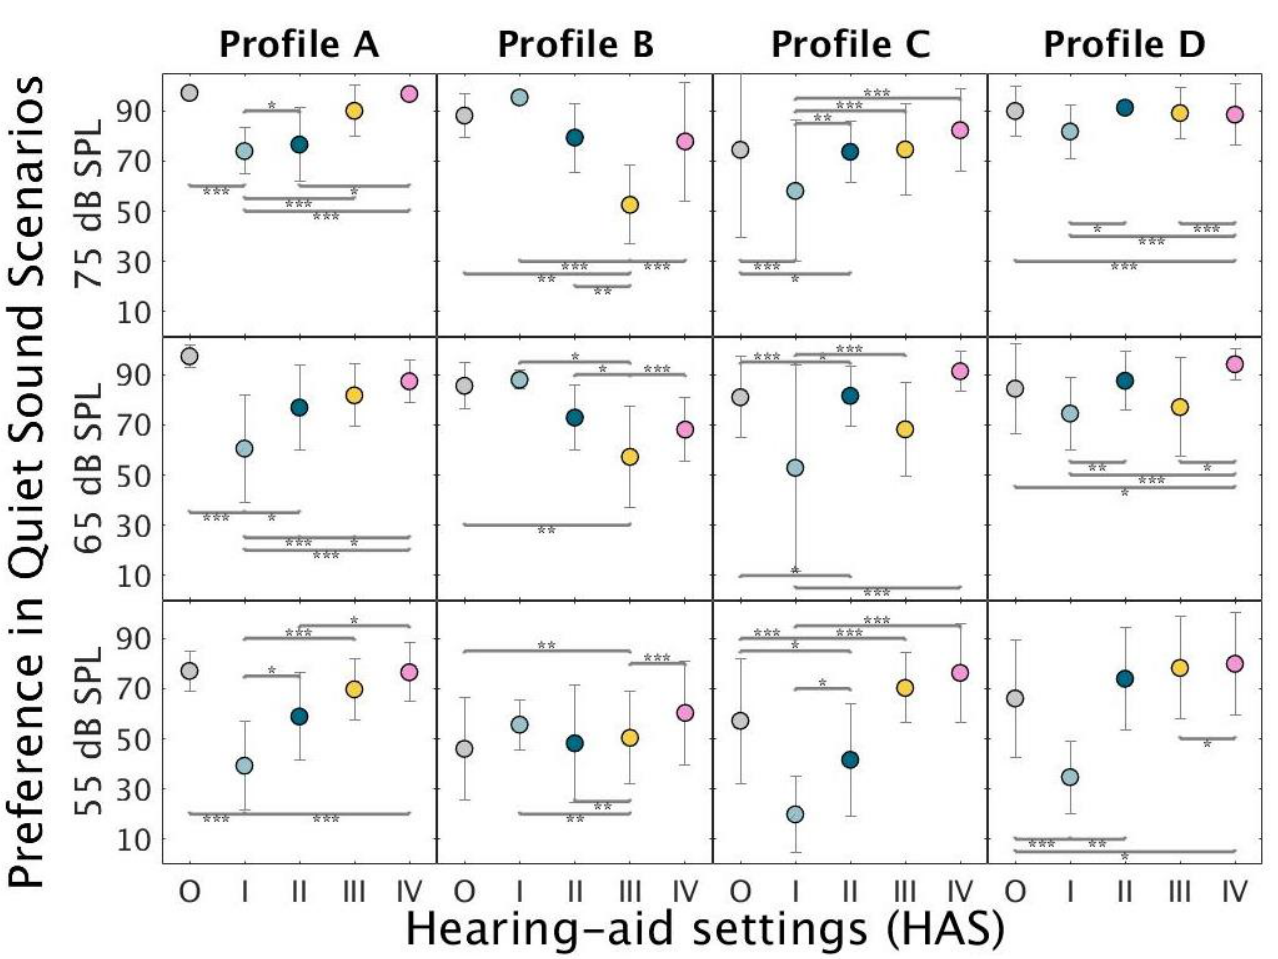
Figure 3. Mean preference ratings for the evaluated HAS (O-IV) in the “Quiet” sound environment across three level conditions: 55 dB SPL (bottom panels), 65 dB SPL (middle panels) and 75 dB SPL (top panels). The circles represent the mean of the scores of the three repetitions performed by the listeners belonging to profile A ( left ), B ( mid-left ), C ( mid-right ), and D ( right ). Error bars show ±1 standard deviation. Significant differences according to a linear mixed model (Appendix A) analysis followed by Tukey’s honest significant differences tests are marked by asterisks. (***) p < 0.0001, (**) p < 0.001, (*) p <